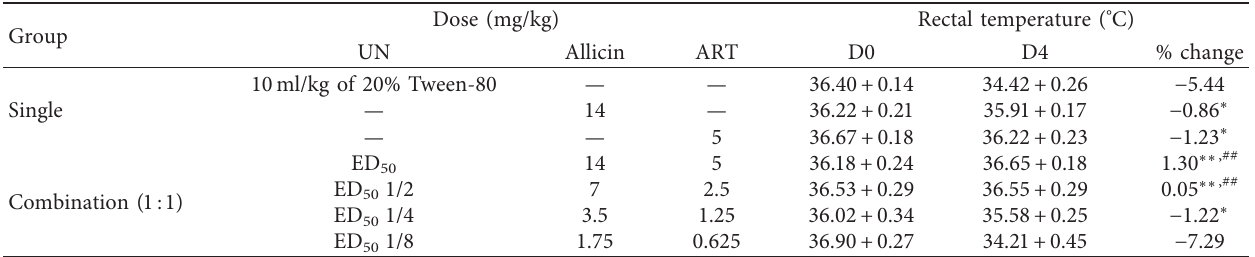
Table 4: Effect of allicin and its combination with ART on rectal temperature in PbANKA infection in mice. Group